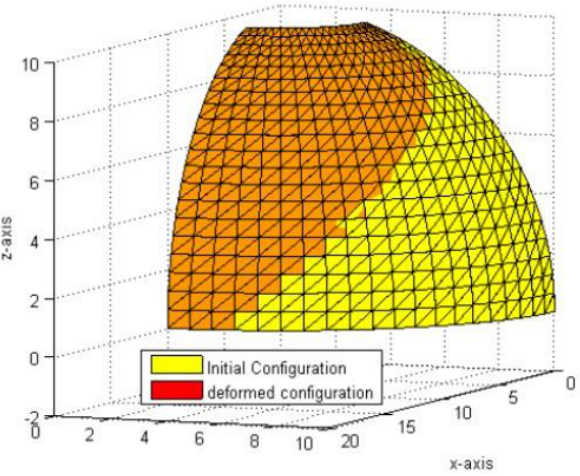
Figure 8: Hemisphere deformed